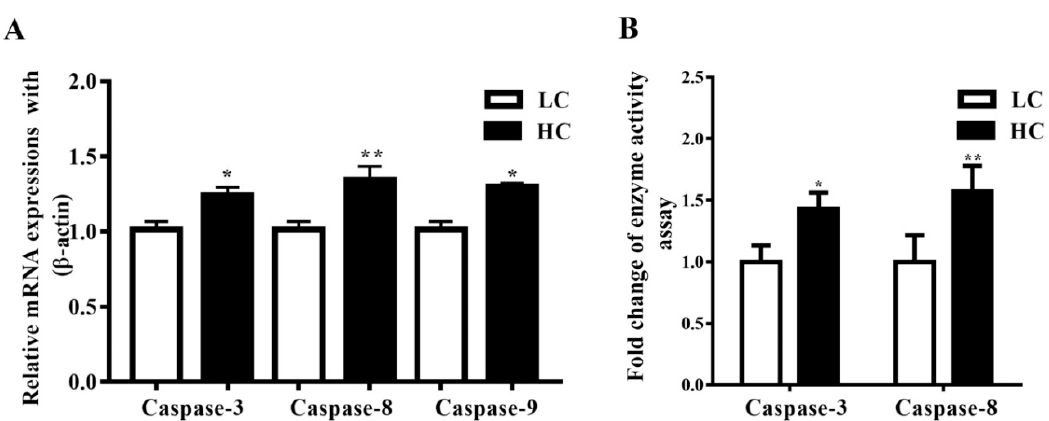
Figure 3. ( A ) In the mammary gland tissue, the mRNA expression of Caspase-3, Caspase-8, and Caspase-9 was markedly increased in the HC group compared to the LC group. ( B ) The concentration of Caspase-3 was markedly higher in the HC group than in the LC group. However similar mRNA trends were exhibited by Caspase-8. * p < 0.05 and ** p < 0.01 versus control.